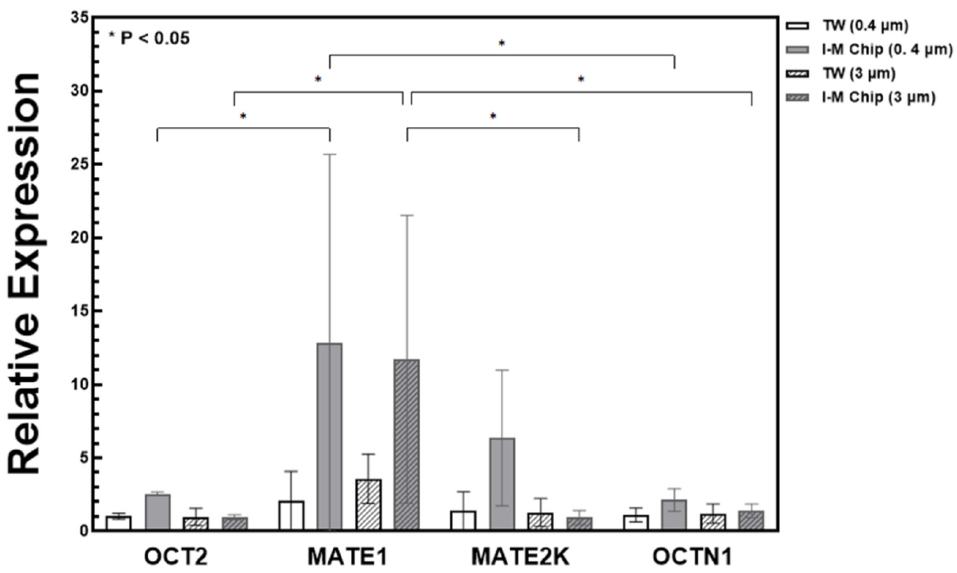
Figure 6. Quantitative PCR (qPCR) expression comparison results analysis. Relative expression levels of OCT2, MATE1, MATE2K, and OCTN1. Overall, it was shown that the gene expression level in chip was increased compared to transwell (* p < 0.05).